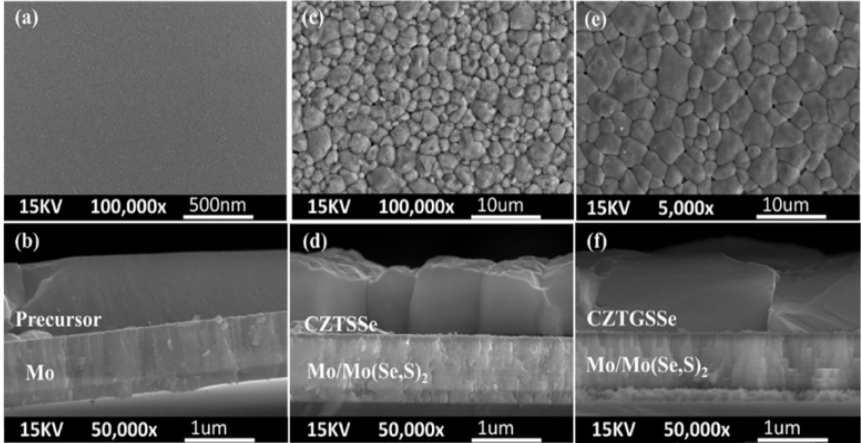
Figure 1. Surface and cross section SEM images of the ( a , b ) precursor film; ( c , d ) Cu 2 ZnSn(S,Se) 4 (CZTSSe) film; and ( e , f ) Cu 2 Zn(Sn,Ge)(S,Se) 4 (CZTGSSe) film.